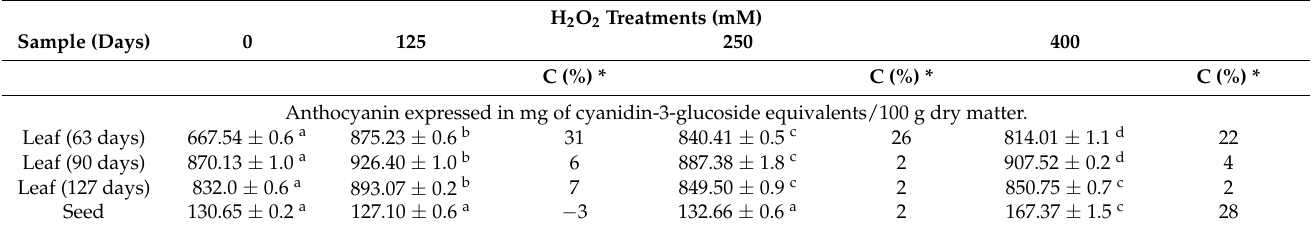
Table 6. Anthocyanin content in amaranth leaf and seed ( Amaranthus hypochondriacus